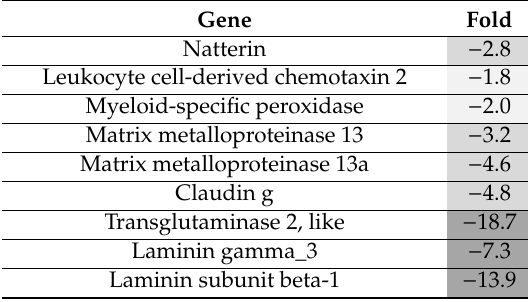
Figure 5. SEM images of Atlantic cod and polar cod skin after exposure to the high dose of H 2 O 2 . Exposed skin from Atlantic cod showed ( A ) cranks in the skin structure (arrows); enlarged in ( B ), showing lost cells (white arrow), loose cells (black arrow) and reduced microridges (hollow arrow); ( C ) exposed skin from polar cod had cranks (white arrow) and increased number of mucous cells at the surface; square enlarged in ( D ) showing mucous cells (white arrow) and reduced microridges (hollow arrow). Table 1. Microarray results. Genes that responded to H 2 O 2 exposure in the skin of polar cod. Data are ratio of exposed to control skin (fold change) (Supplementary Materials